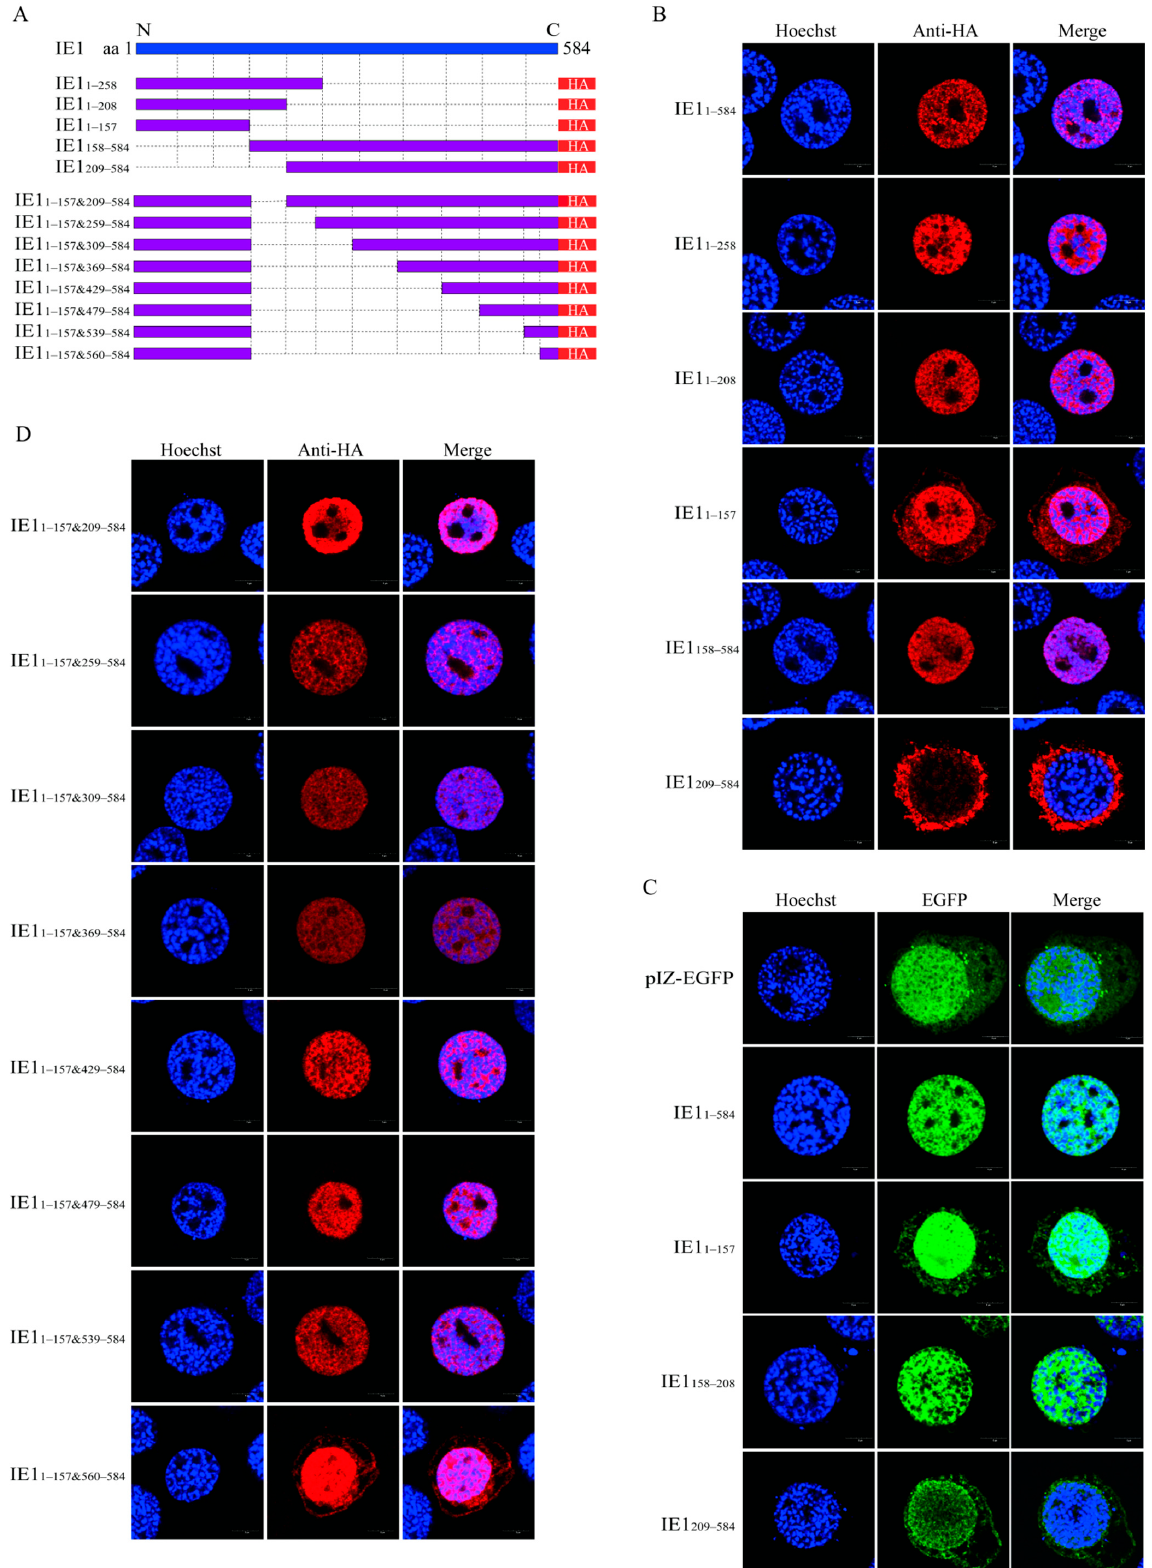
Figure 3. Identification of nuclear localization elements of BmNPV IE1. ( A ) Schematic of the construction of IE1 truncated mutants. ( B ) Subcellular localization of IE1 N-terminal and